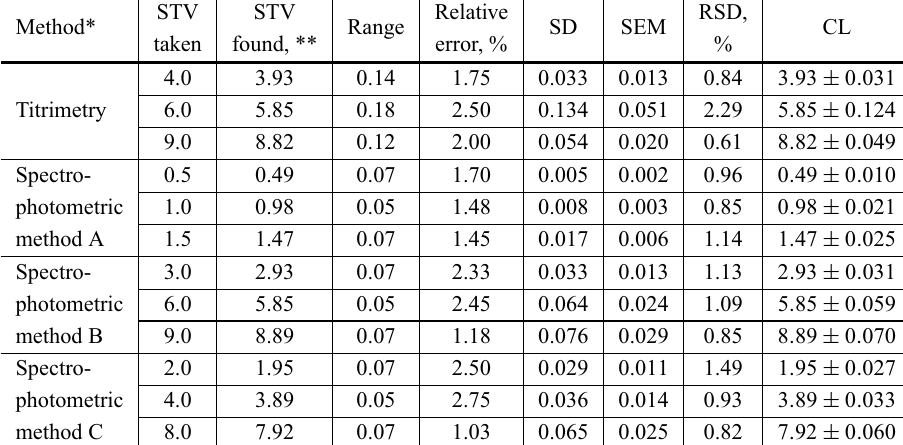
Intra-day accuracy and precision of the methods.